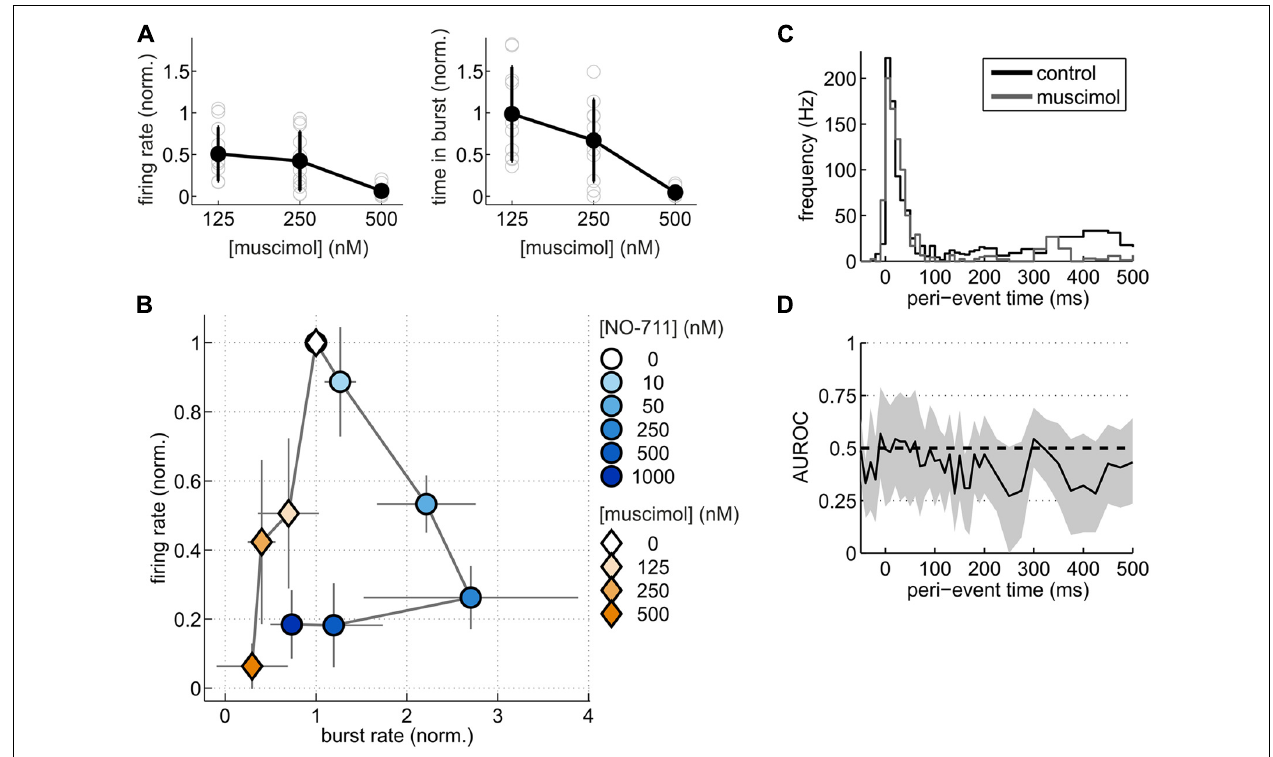
FIGURE 8 | Spontaneous activity patterns induced by NO-711 and the GABA-mimetic muscimol. (A) Concentration–response relationships of muscimol for average firing rate (left) and proportion of time spent in bursts (right). (B) Plot of average firing rate versus burst rate for NO-711 data and muscimol data.The data were normalized to the respective control conditions. Symbols and lines correspond to means and standard